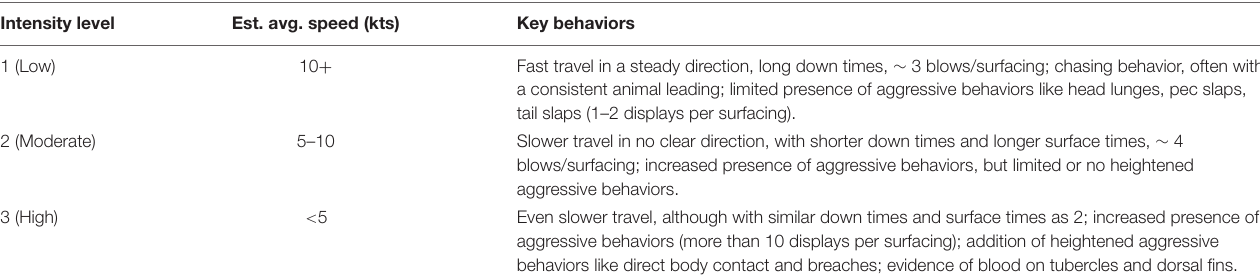
TABLE 2 | Intensity scale developed for competitive groups based on the behaviors outlined in the ethogram and observations of speed and breathing